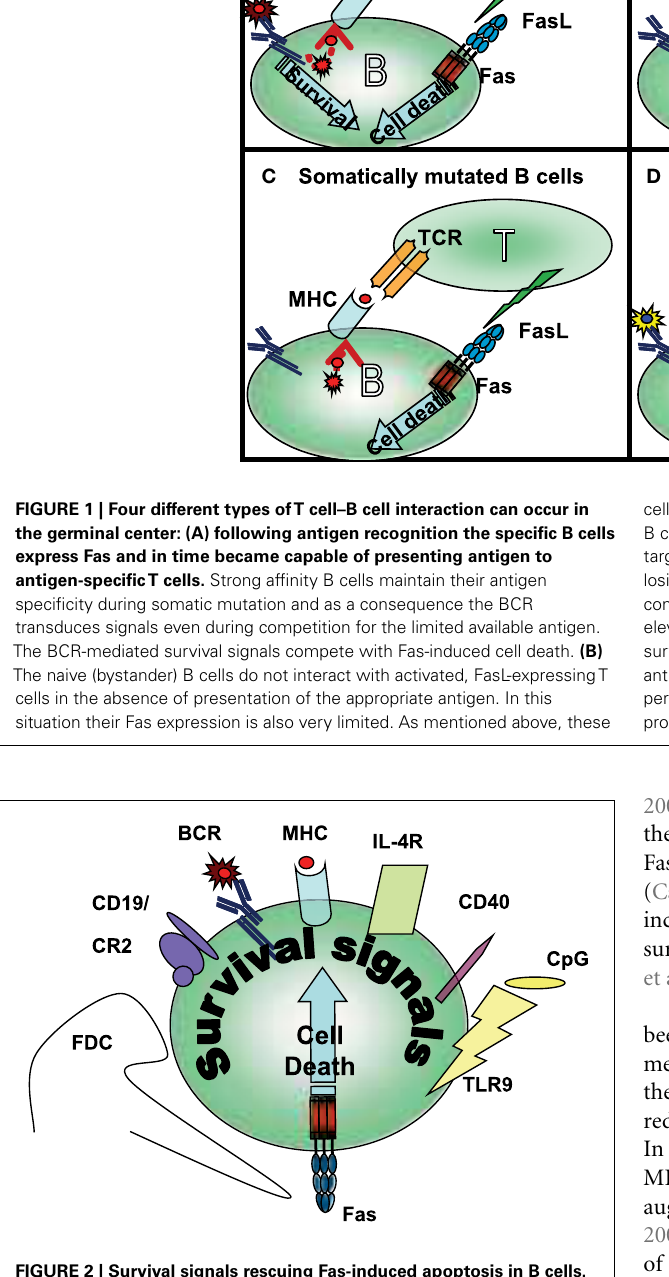
FIGURE 2 | Survival signals rescuing Fas-induced apoptosis in B